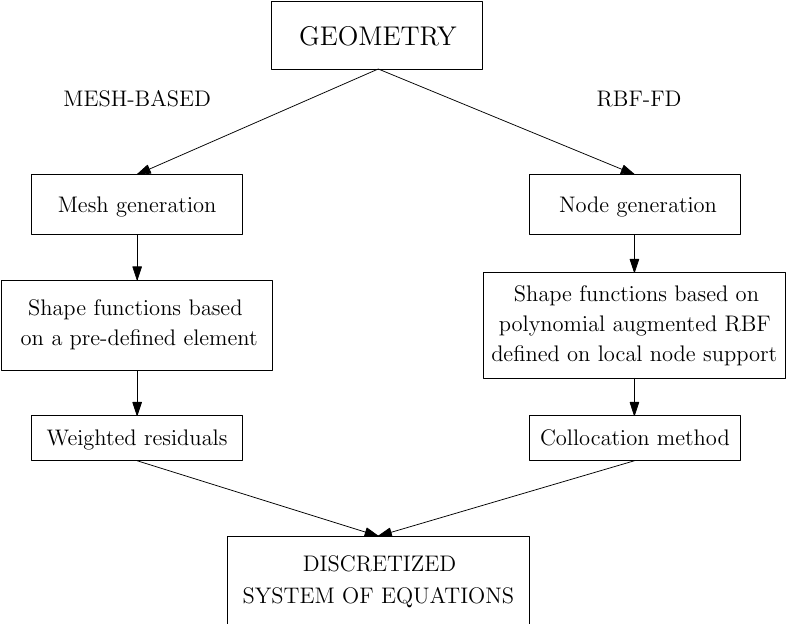
Figure 1. Flowchart for FEM and meshless methods, inspired by that reported in